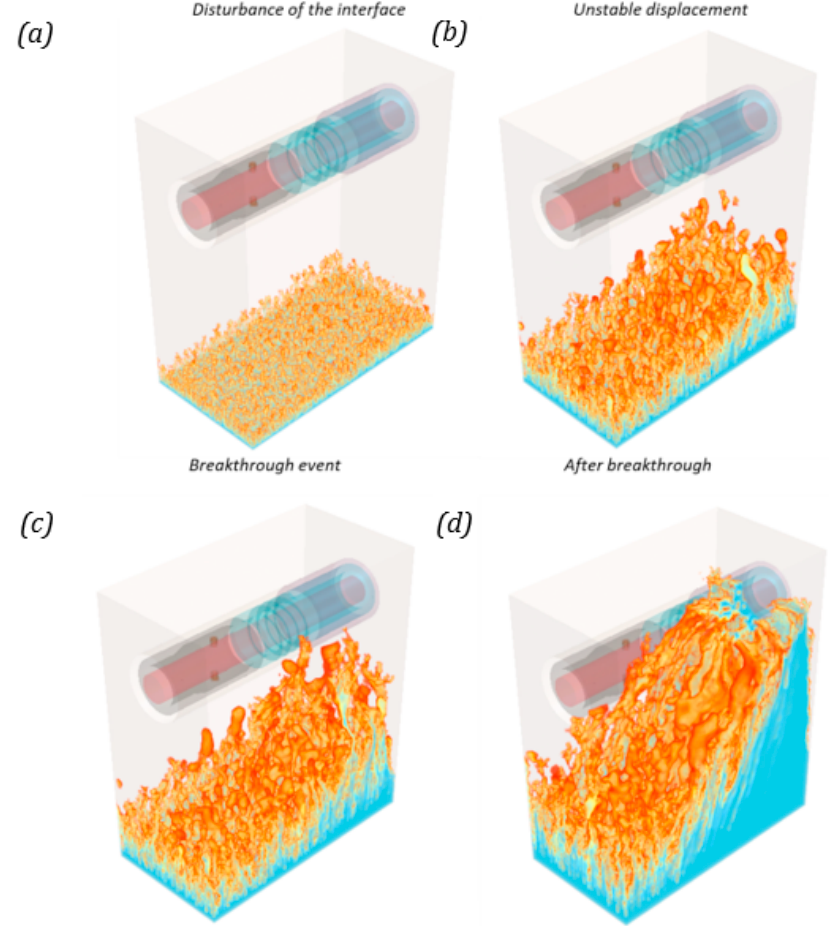
Figure 8. Rendering of viscous fingering during the breakthrough in the completion assembly, ( a ) Initial displacement or disturbance of the interface, ( b ) Viscous Fingering and unstable displace- ment, ( c ) The breakthrough event, and ( d ) Water production after the breakthrough